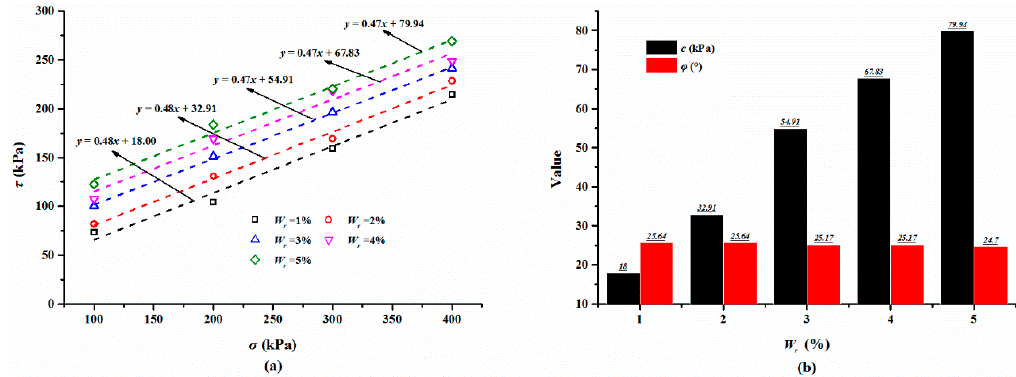
Figure 13. ( a ) The linear relationship between the shear stress τ and normal stress σ ; ( b ) The relationship between the shear strength parameters ( c and φ ) and the polymer content W r .